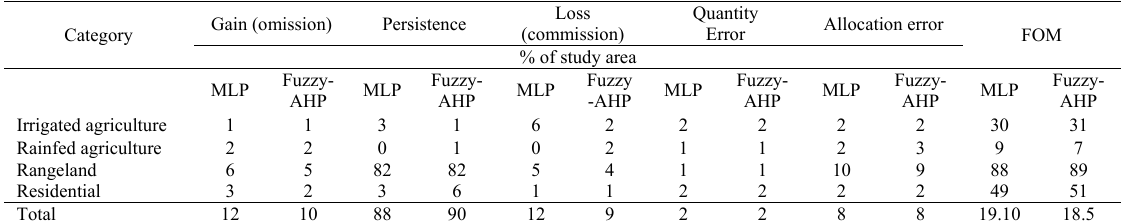
Table 6: Validation metrics for each land use class and total landscape using three-dimensional approach Category